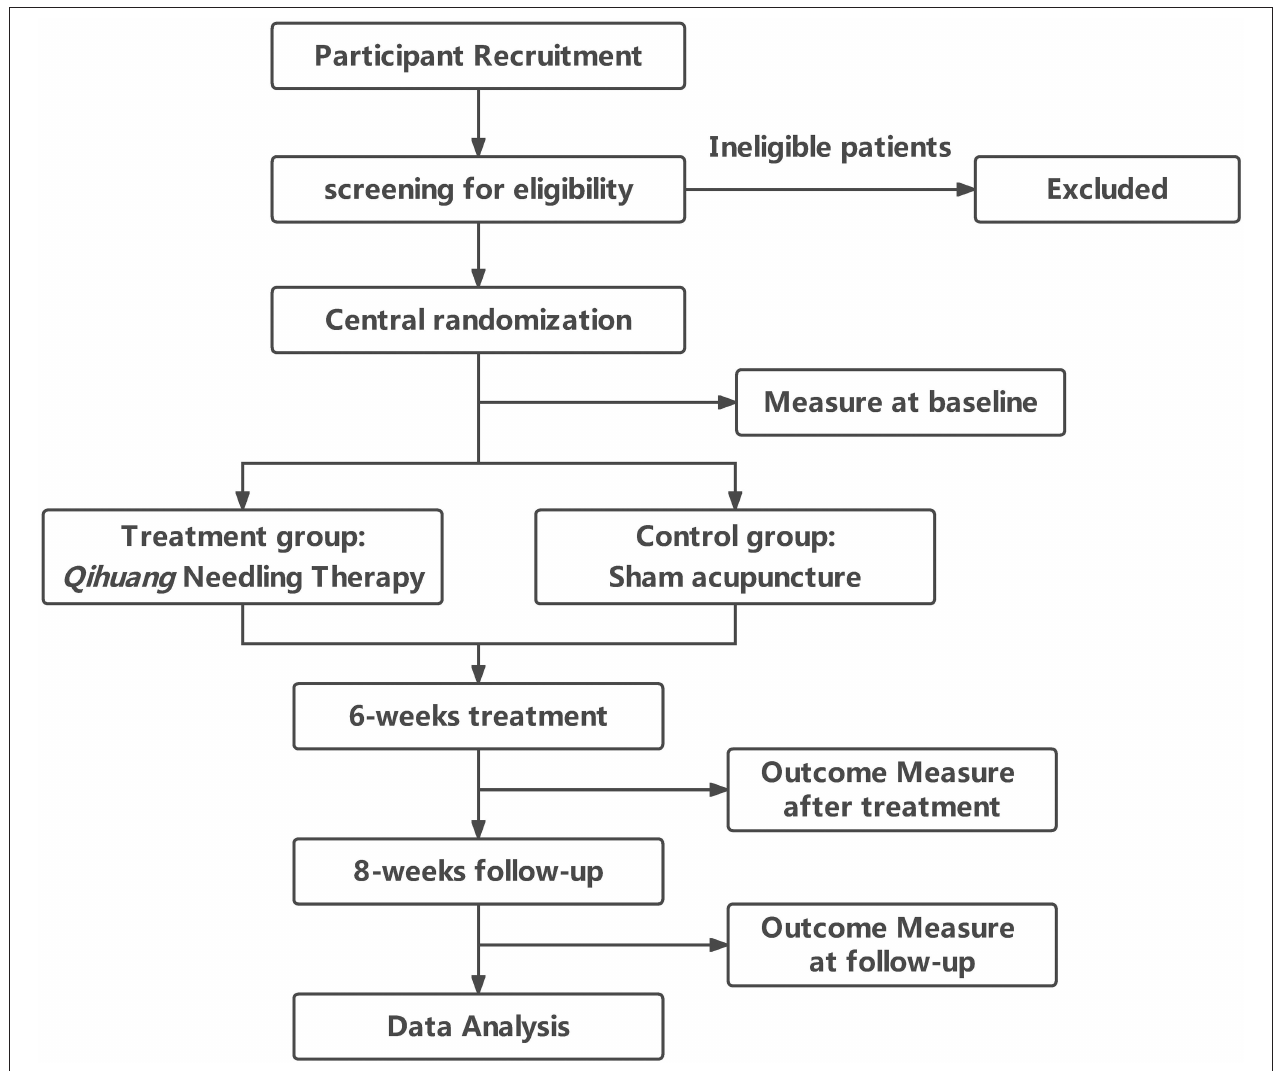
FIGURE 1 | Trial flow